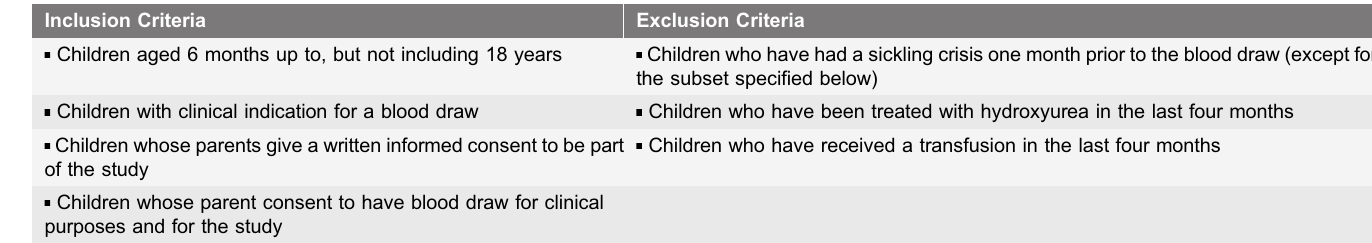
Table 1. Inclusion and Exclusion Criteria for Study.